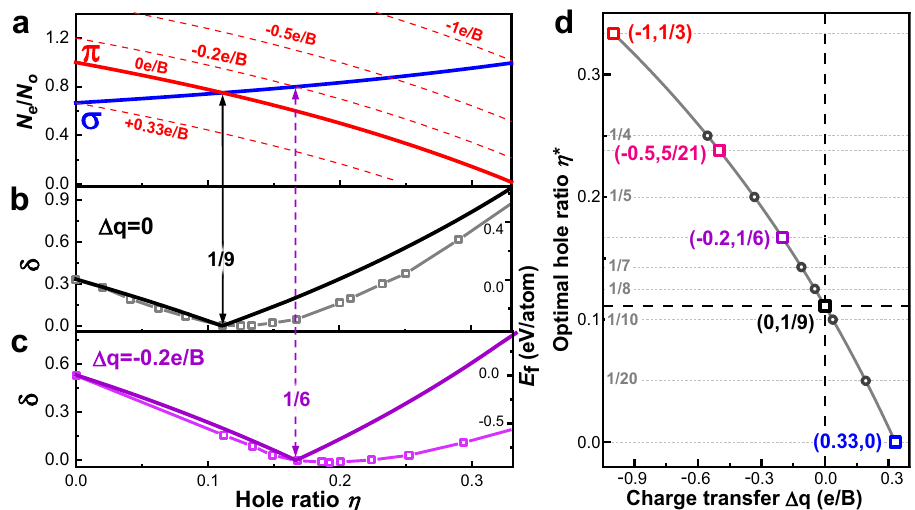
Fig. 5 | Borophene stability analysis at different doping levels. a Electron-to- orbital occupation ratios N e = N o of π (red) and σ (blue) bonding con fi gurations of neutral (solid curves) and doped (dash curves) borophene isomers as functions of hole ratio η . b - c Occupation imbalance factor δ =| N π e = N π o (cid:1) N σ e = N σ o | of ( b ) neutral borophene ( Δ q=0) and ( c ) borophene with charge transfer of − 0.2e per B atom as